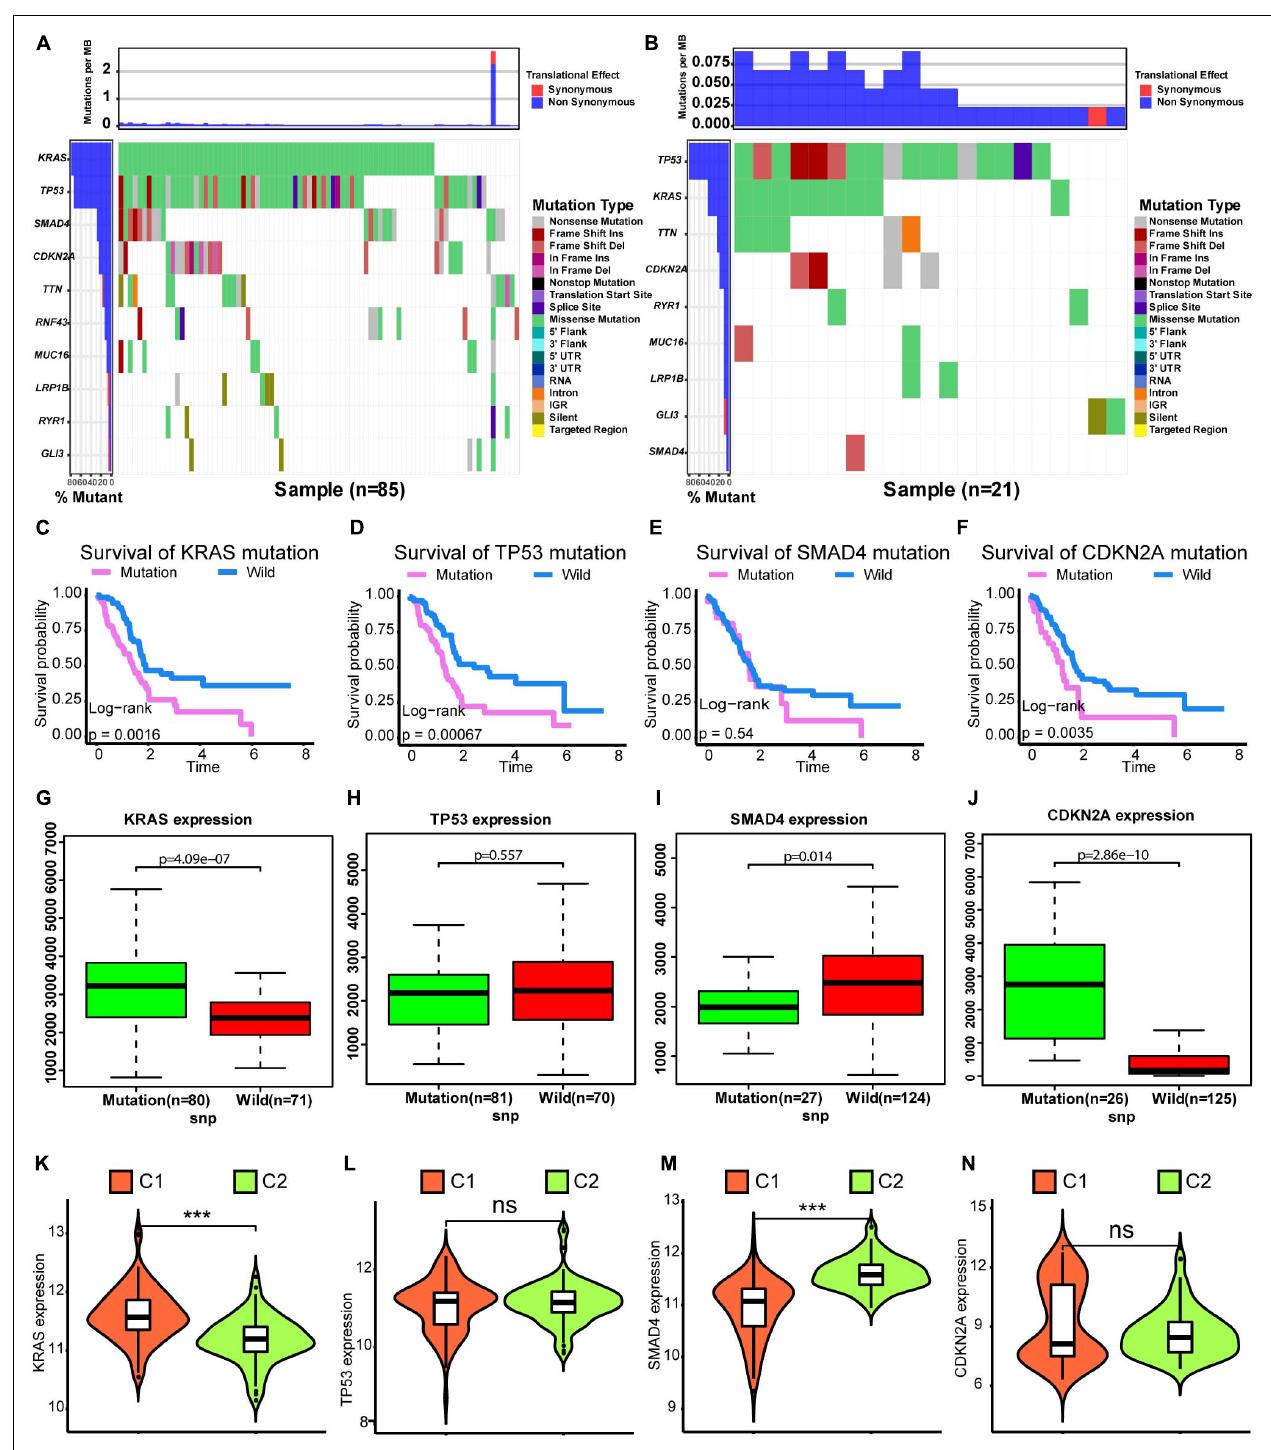
FIGURE 3 | Differences in SNVs between C1 and C2 subtypes. (A) Waterfall plot for the C1 subtype. (B) Waterfall plot for the C2 subtype. (C–F) Kaplan–Meier survival analysis of patients with mutations in KRAS , TP53 , SMAD4 , and CDKN2A . P- values obtained via log-rank tests are shown. (G–J) Boxplots illustrating correlations between gene expression levels and SNVs for KRAS , TP53 , SMAD4 , and CDKN2A . (K–N) Violin plots exhibit differences in expression levels of KRAS , TP53 , SMAD4 , and CDKN2A between C1 and C2 subtypes. Wilcoxon test P -values are shown. SNV: simple nucleotide variation. P < 0.05 was defined as statistically